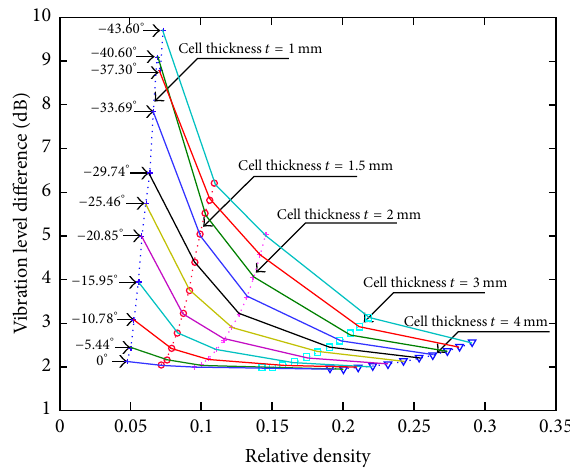
Figure 8: Acceleration vibration level difference of auxetic cellular base variation against the relative